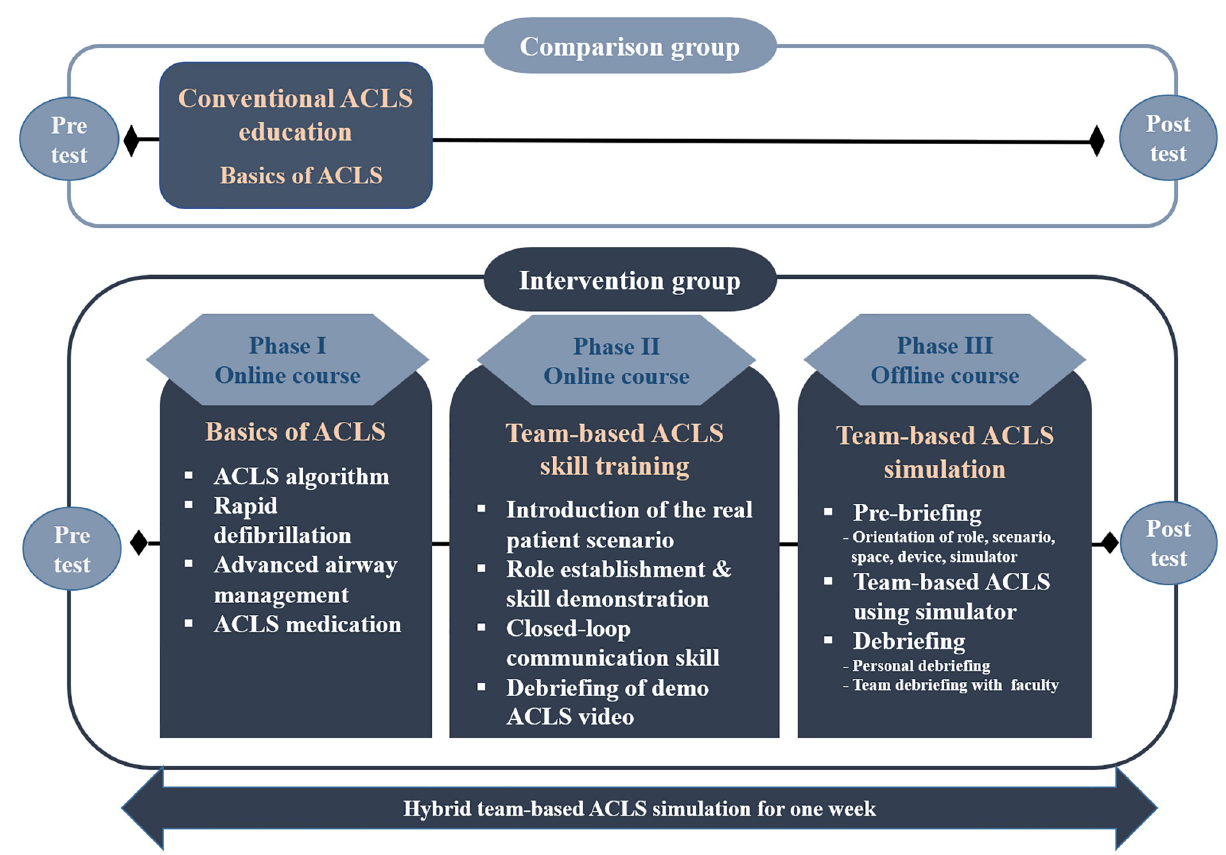
Fig 2. Research design and simulation program in this